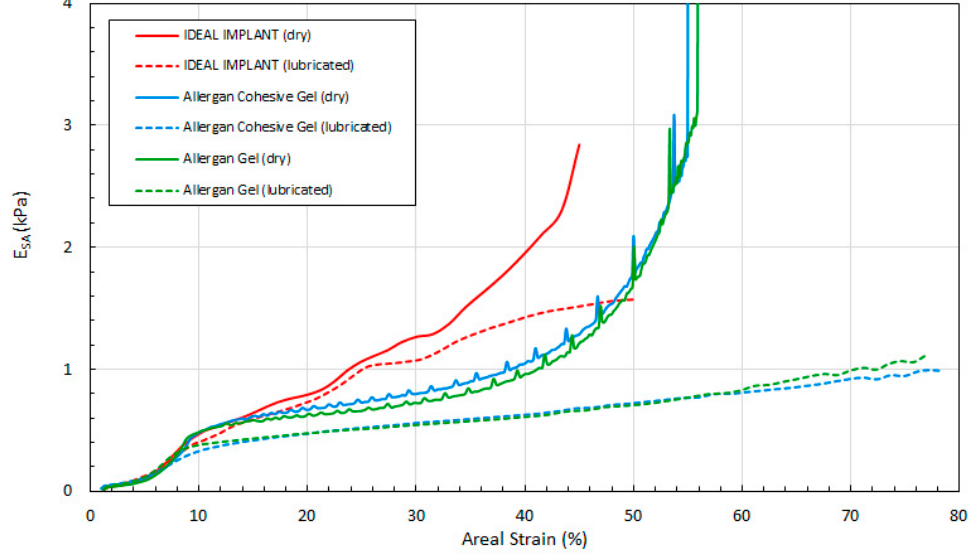
Figure 15. Diametric Tangent Modulus with Diametric Strain, Dry and Lubricated Platens.